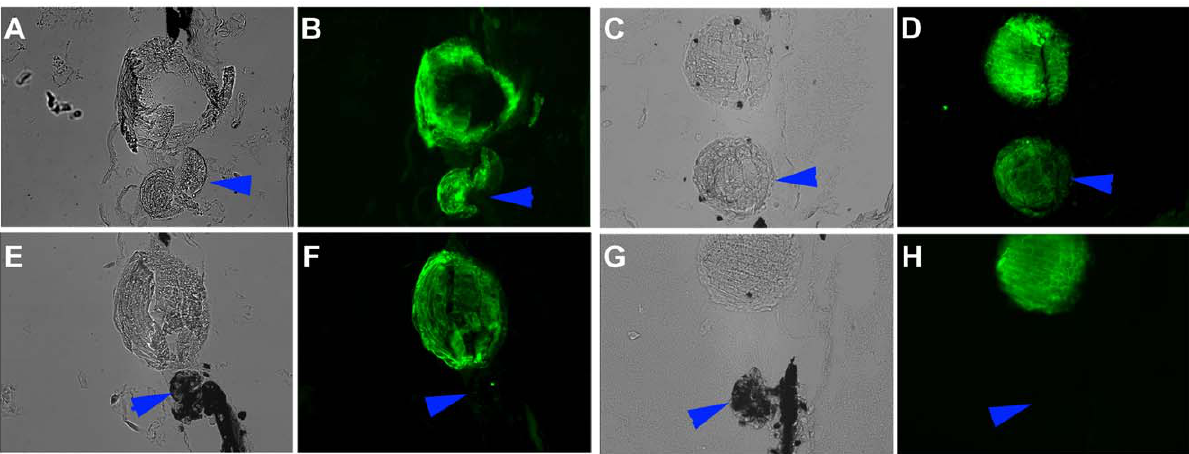
Figure 3. Loss of function. Effects of miR-148 and let-7b down-regulation on the capability of dorsal and ventral PECs to transdifferentiate to lens. Same description as in Figure 2 legend.